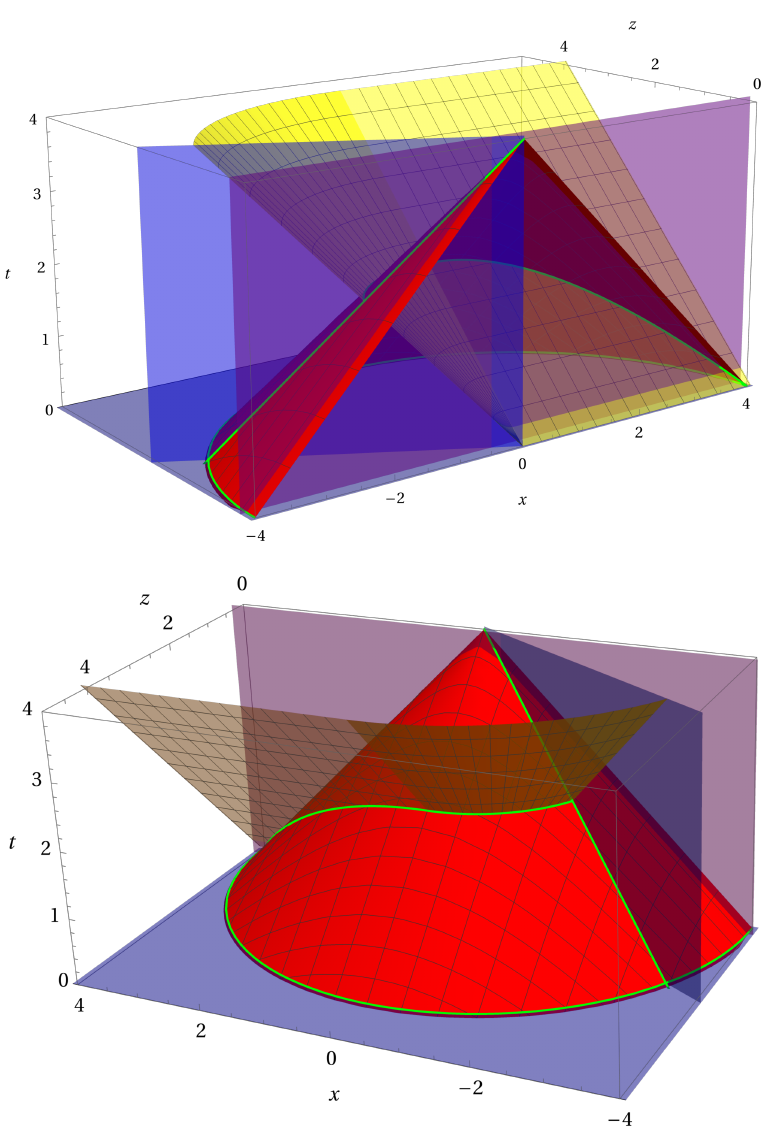
Figure 6 . Geometrical sketch of the null boundaries of the WDW patch (light yellow surfaces) and of the entanglement wedge (red), taken from two different perspectives. The blue plane represents the brane and restricts the intergration to the region x ≥ − z cot α . The purple transparent region represents the cutoff surfaces located at z = δ . There are several curves depicted in green representing the intersections between the WDW patch, the entanglement wedge and the brane. In the figure we take α = π/ 6